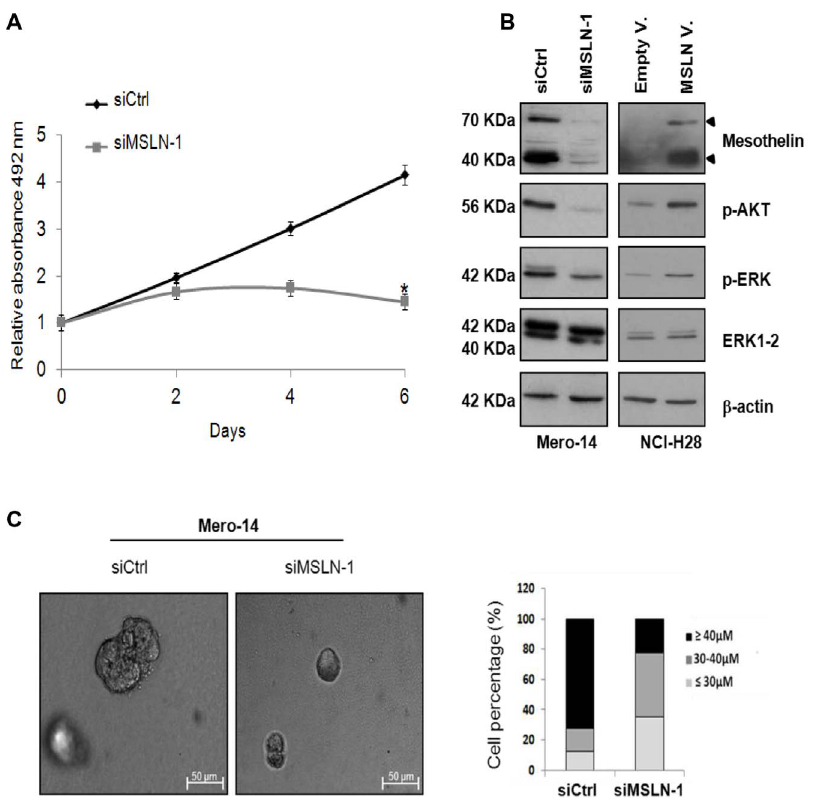
Figure 2. Role of MSLN in cellular growth. A. SRB proliferation assay in Mero-14 cells treated with 40 nM of the siCtrl or siMSLN-1 (*P = , 10 2 4 ). Error bars represent SEM of three independent experiments, each performed in quadruplicate. B. Western blotting analysis of MSLN, p-AKT, p-ERK, and ERK1-2, on Mero-14 cells treated with siCtrl, or siMSLN-1, and on NCI-H28 cells transfected with an empty vector (pcDNA3.1) or a plasmid overexpressing MSLN (pcDNA3.1-MSLN). b -actin was used as reference. The protein levels were confirmed with three independent experiments. C . The picture represents the phase contrast microscopy of Mero-14 cells cultured in 3D Matrigel-overlay chambers after silencing of MSLN (siMSLN-1 at 40 nM). Magnification 10X. Two different experiments were performed, each in triplicate. The percentages of Mero-14 cells classified according to the dimensions of the spheres following treatments with siCtrl or siMSLN-1 in 3D Matrigel-overlay chambers were also reported. Legend to figure 2 : Gray line= cells treated with siMSLN-1; Dark line= cells treated with